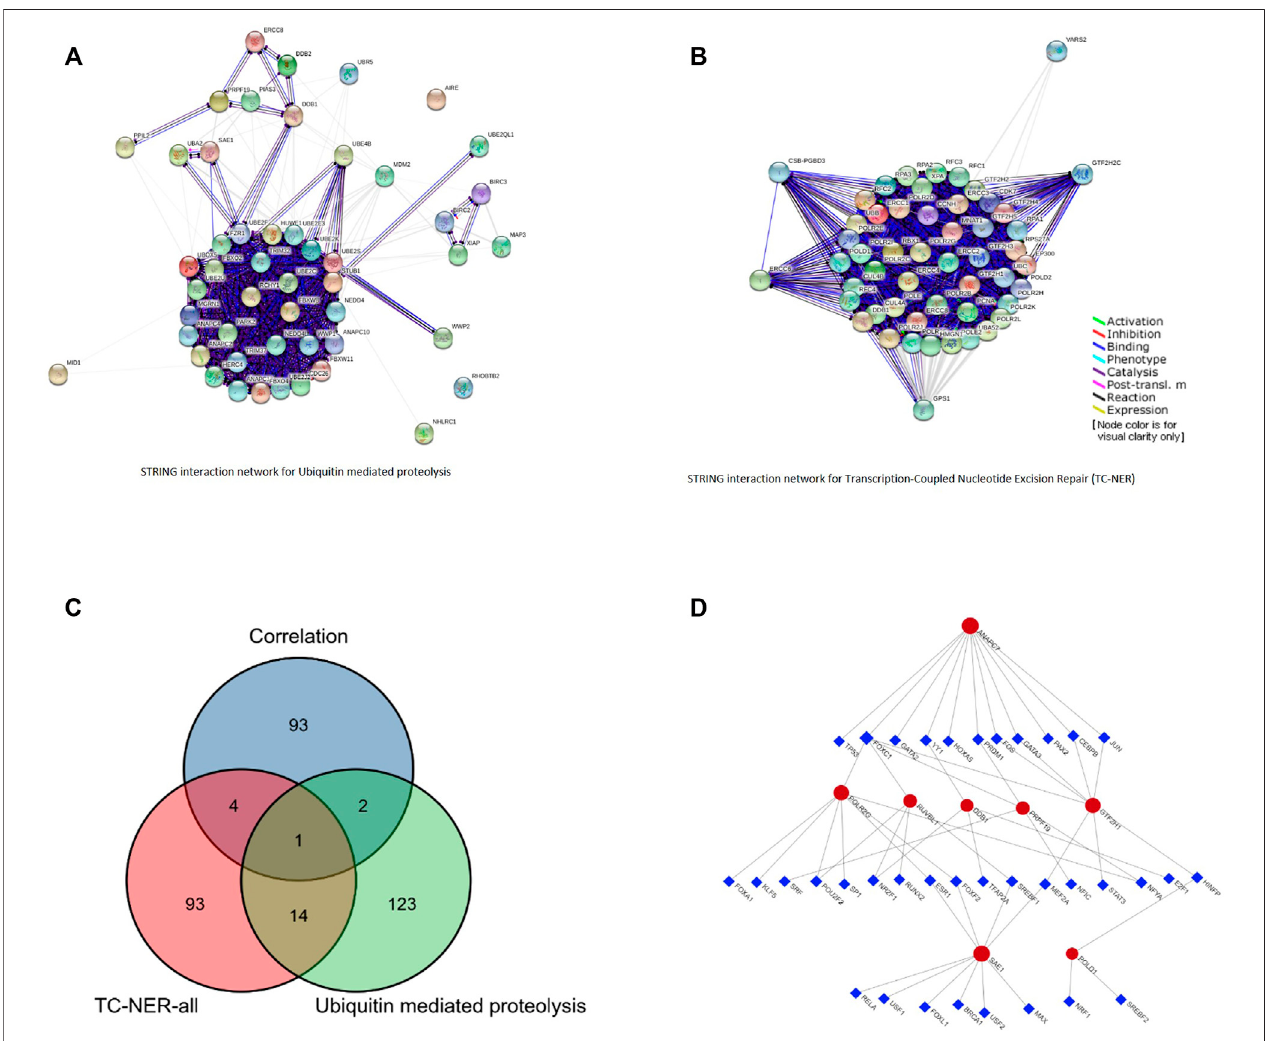
FIGURE 6 | Pathway network for PRPF19-related. (A) The interaction network of ubiquitin-mediated proteolysis. (B) The interaction network of transcription- coupled nucleotide excision repair (TC-NER). (C) The interaction network of 100 positive correlated genes, 112 genes in ubiquitin-mediated proteolysis pathway, and 140 genes in TC-NER pathway. (D) TF – eight network generated by NetworkAnalyst software. The regulation network of 36 TFs and 8 mRNAs.